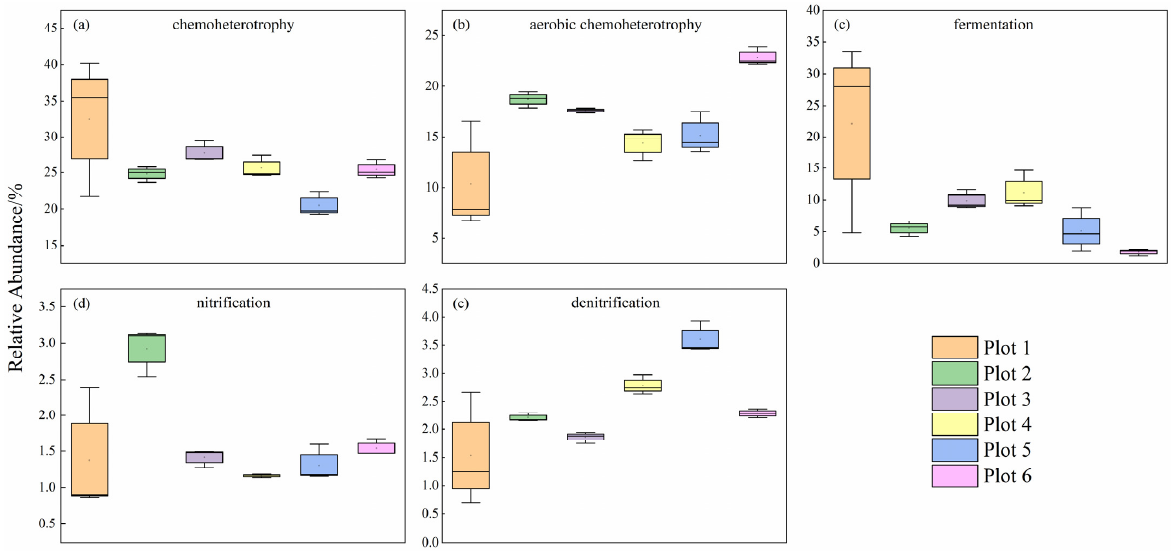
Figure 6. Changes in soil bacterial ( a – e ) potential functional groups in different plots. The range of the box is the mean ± SD, the vertical line shows the 10th to 90th percentile, and the horizontal black line in the box is the median values.